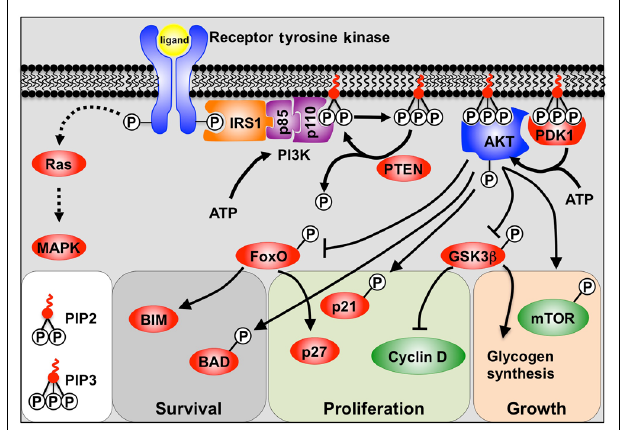
FIGURE 1 |A model depicting PI3K signaling. Binding of the receptor tyrosine kinase ligand activates receptor auto-phosphorylation, leading to recruitment of substrate proteins such as IRS-1.This leads to recruitment of the regulatory (p85) and catalytic (p110) subunits of class 1a PI3K. PI3K phosphorylation of PIP 2 to PIP 3 allows PIP 3 to act as a secondary messenger within the inner surface of the cell membrane. AKT and PDK1 bind to PIP3, and PDK1 and mTOR/Rictor activate AKT via phosphorylation. Active AKT is then able to promote cell survival, growth, and proliferation by phosphorylation of key substrates. Also shown is the alternative Ras pathway which can also be stimulated by receptor tyrosine kinases to activate